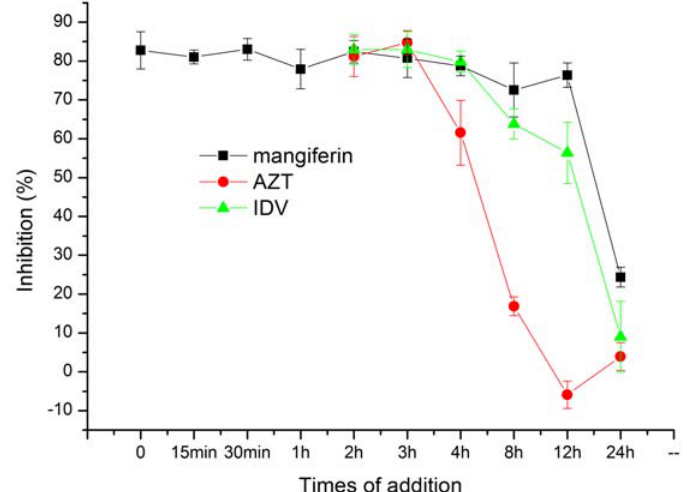
Figure 3. Time-of-addition assay of